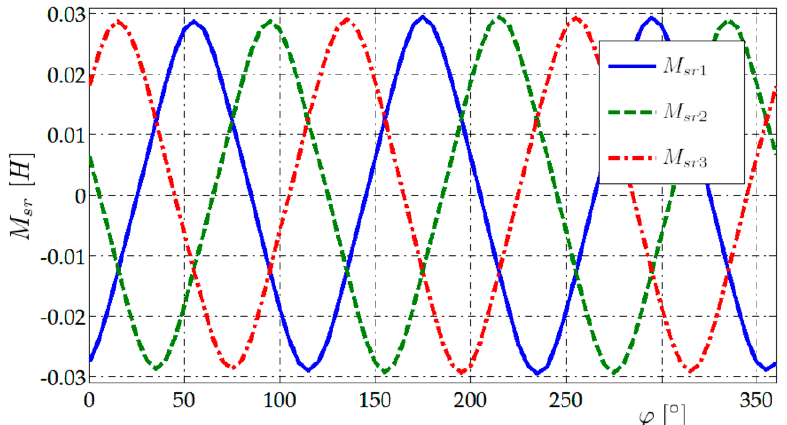
Figure 2. The coefficients of the mutual inductance of the stator windings in relation to the first phase rotor winding versus the rotor rotation angle.